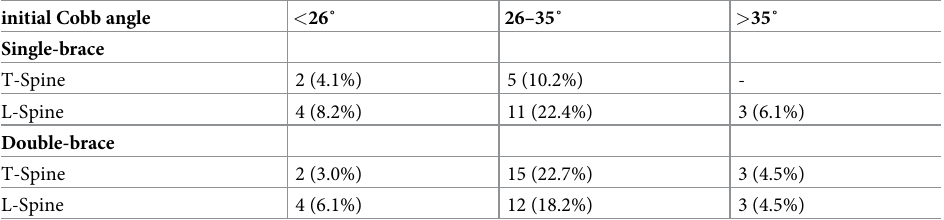
Table 4. Distribution of improvements in both treatment groups sorted by primary curvature and initial COBB- angle value (% of all treated patients with the respective brace